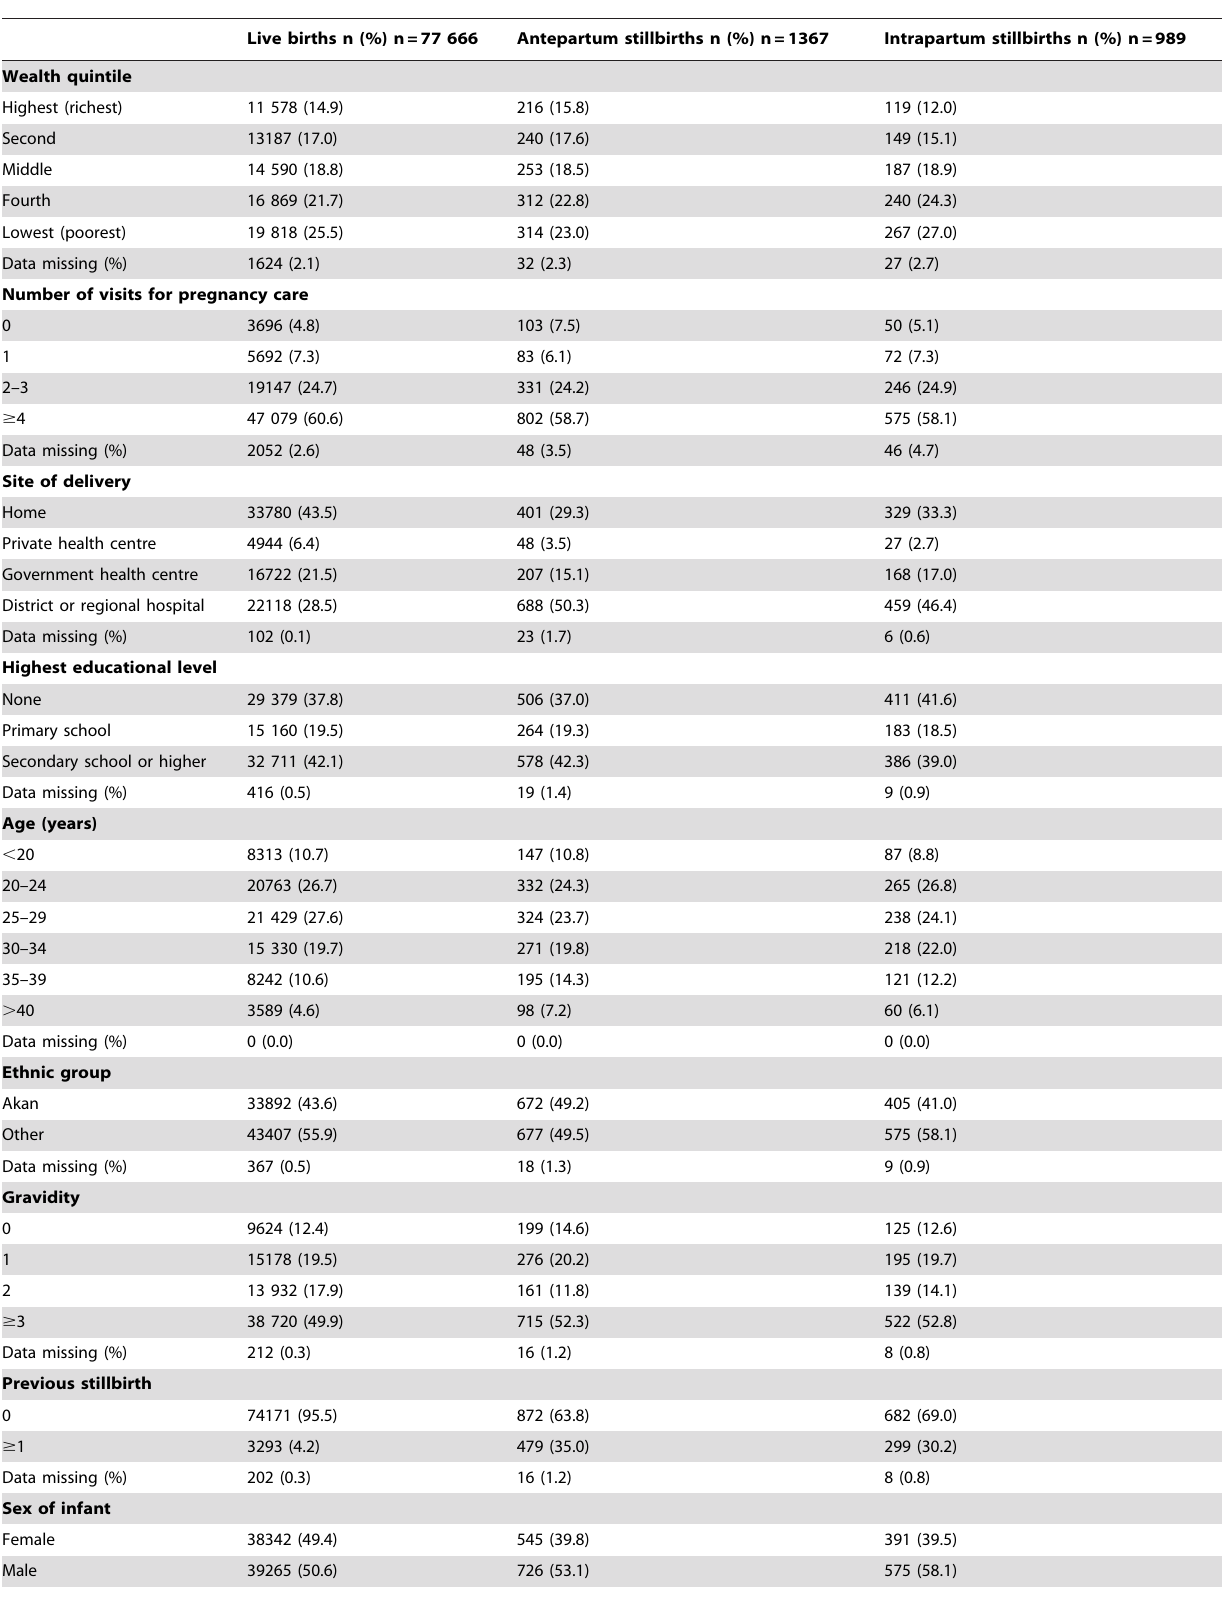
Table 1. Maternal characteristics and antepartum and intrapartum stillbirths, 1 July 2003 to 30 September